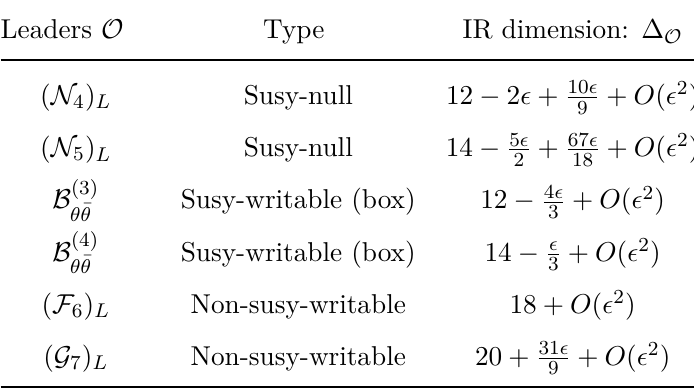
of operators in all symmetry sectors, we can answer with reasonable confidence the question of stability of the fixed